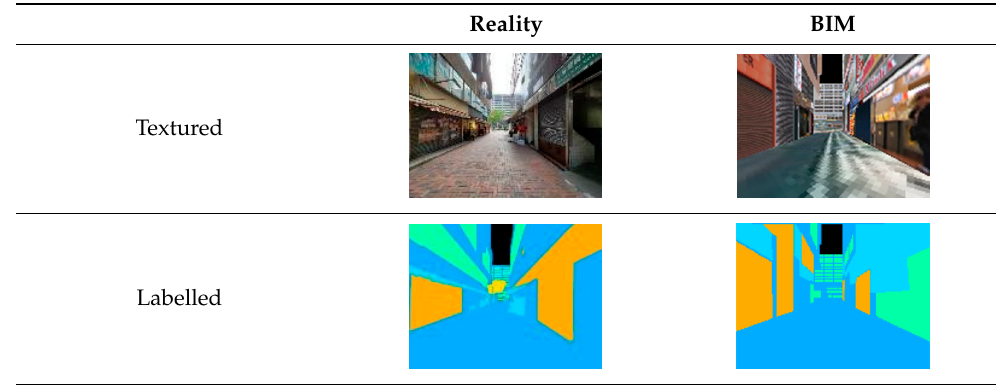
Table 5. Discrepancy between reality and BIM.